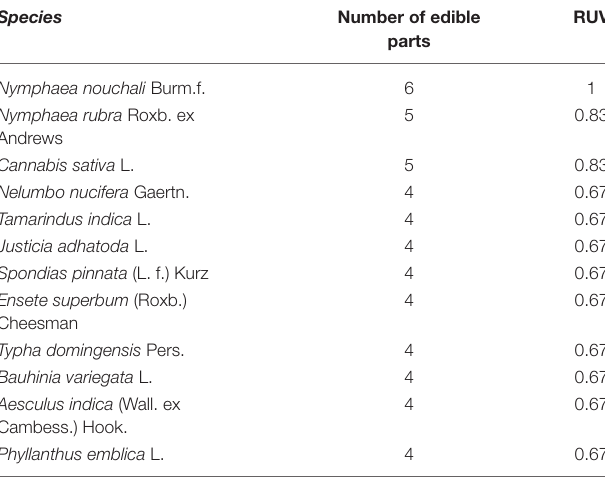
TABLE 3B | A list of species with multiple edible parts and RUV value (between 0.67 and 1). Species Number of edible